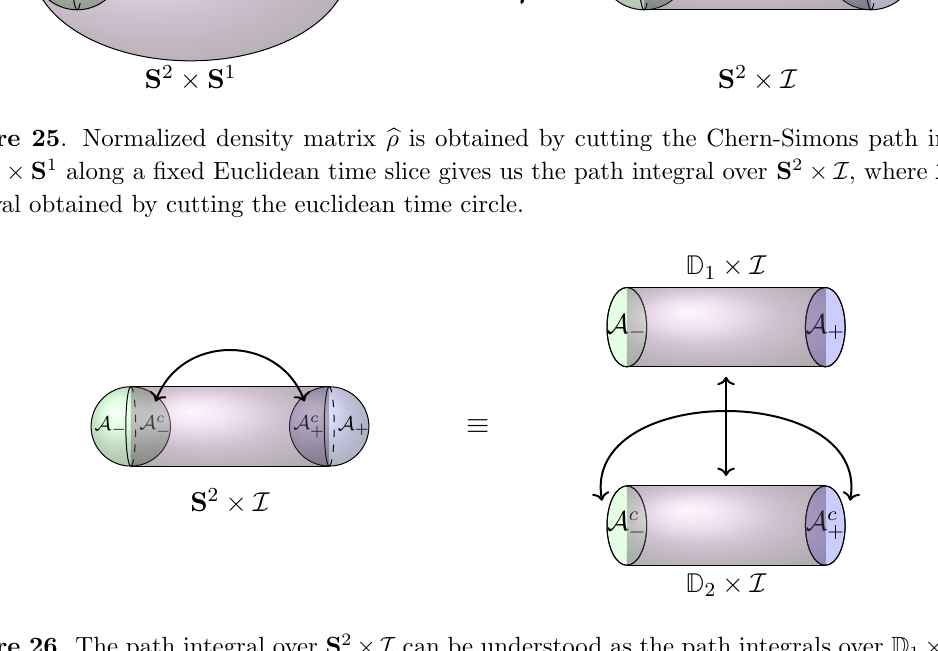
D D 1 (cid:2) I and @ 2 (cid:2) I . The normalized reduced density matrix and A c (cid:0) +